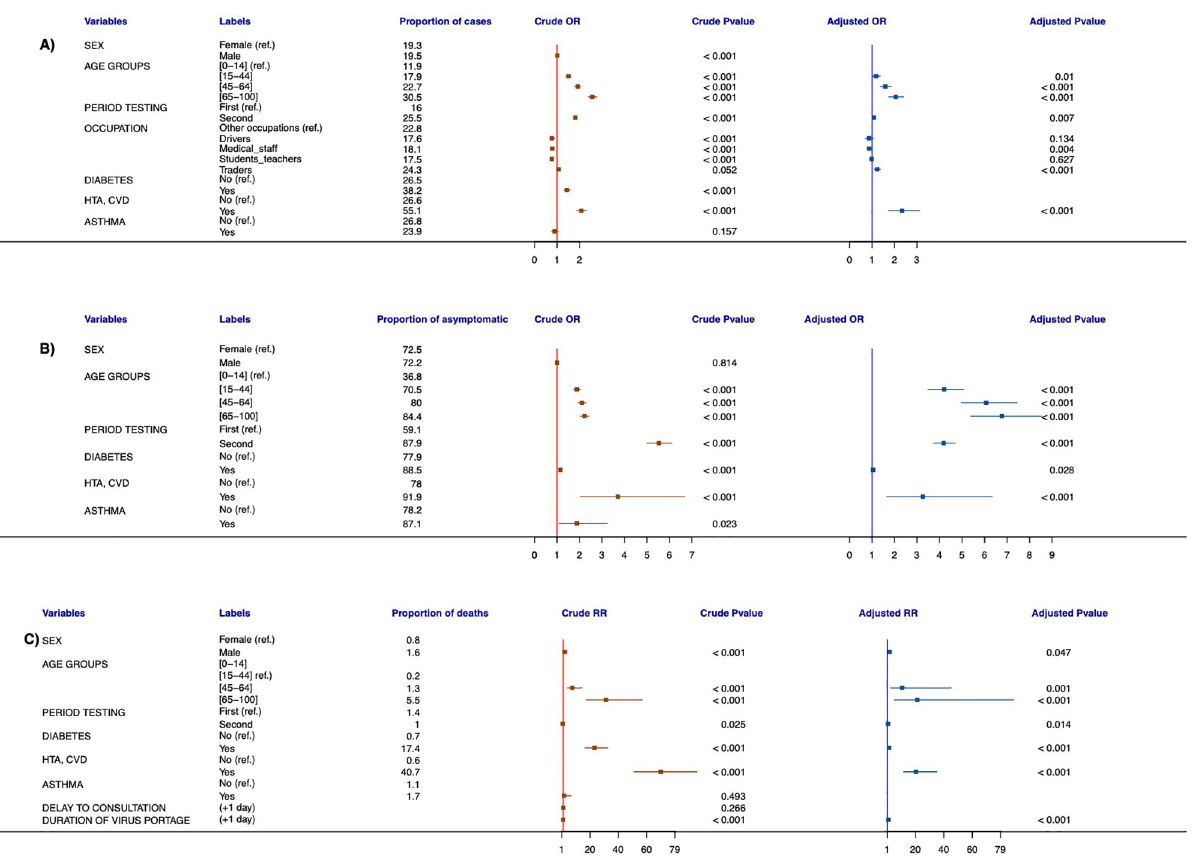
Fig 5. Forest plot for COVID-19 associated factors. A. Forest plot for factors associated with COVID-19 infection. B. Forest plot for factors associated with COVID-19 symptomatic disease. C. Forest plot for factors associated with COVID-19 mortality. Vertical lines (red and blue) represent odds ratio of 1. Red (respectively blue) dots represent crude (respectively adjusted) odds ratio. Red (respectively blue) horizontal lines around dots represent 95% confidence intervals for crude (respectively adjusted) odds ratio.